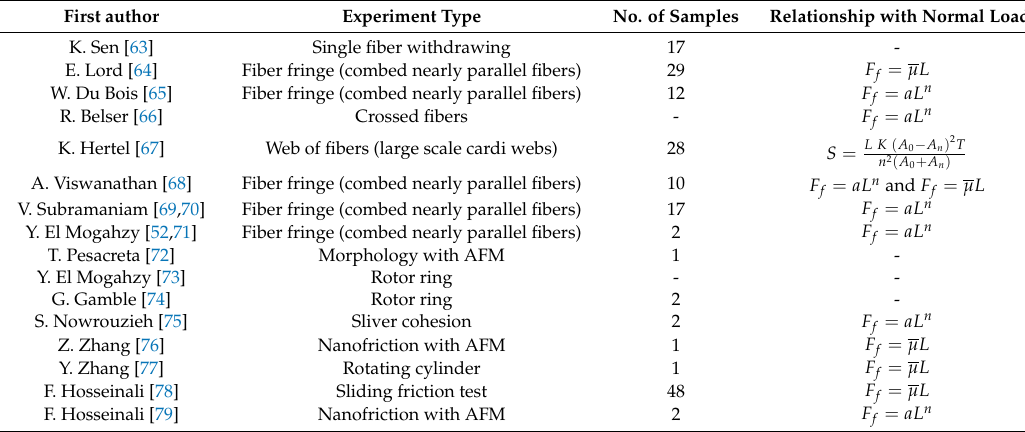
Table 1. Previous studies on frictional properties of cotton fibers ordered by publication date.